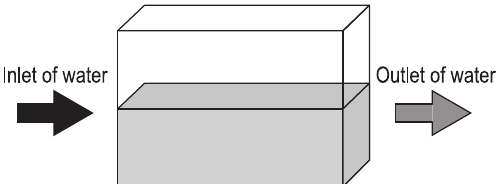
Figure 1. Experimental design of constructed wetlands (CWs), showing planted and unplanted plots with Typha domingensis Pers .